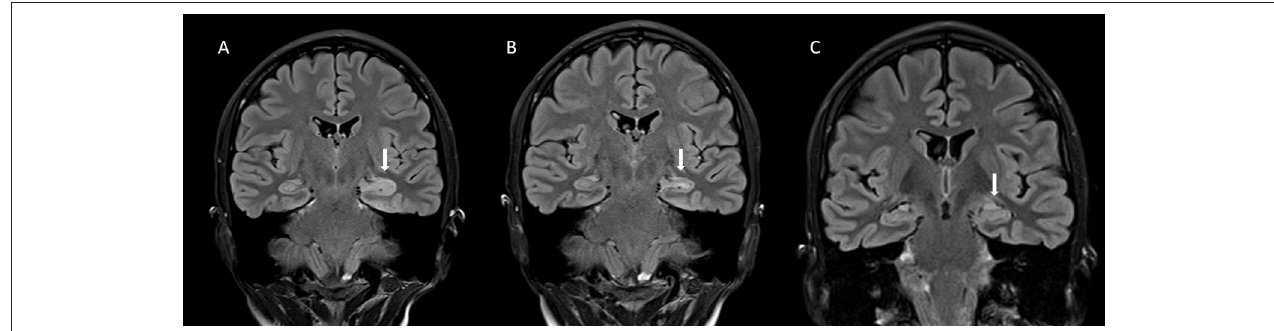
FIGURE 2 | (A) The coronal fluid attenuation inversion recovery (FLAIR) magnetic resonance (MRI) -image taken during the acute stage of the illness shows an abnormally hyperintense and swollen head of the left hippocampus (arrow). (B) Five months later, the finding has mostly resolved, although slight hyperintensity of the left hippocampal head can still be seen (arrow). (C) In a control image, 3 years and 8 months after the acute stage, the abnormal finding has totally resolved (arrow). There are no signs of atrophy in the primarily affected